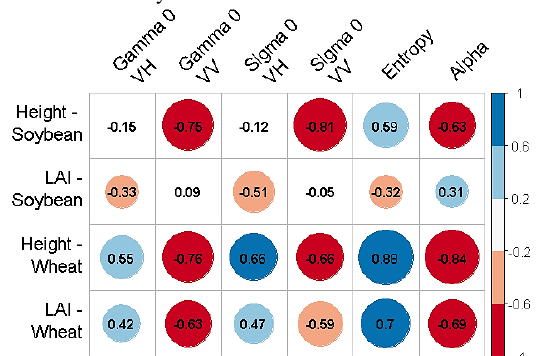
Figure 5. Correlation plot for soybean and wheat. White spaces, without circles, are insignificant at 5% of significance.